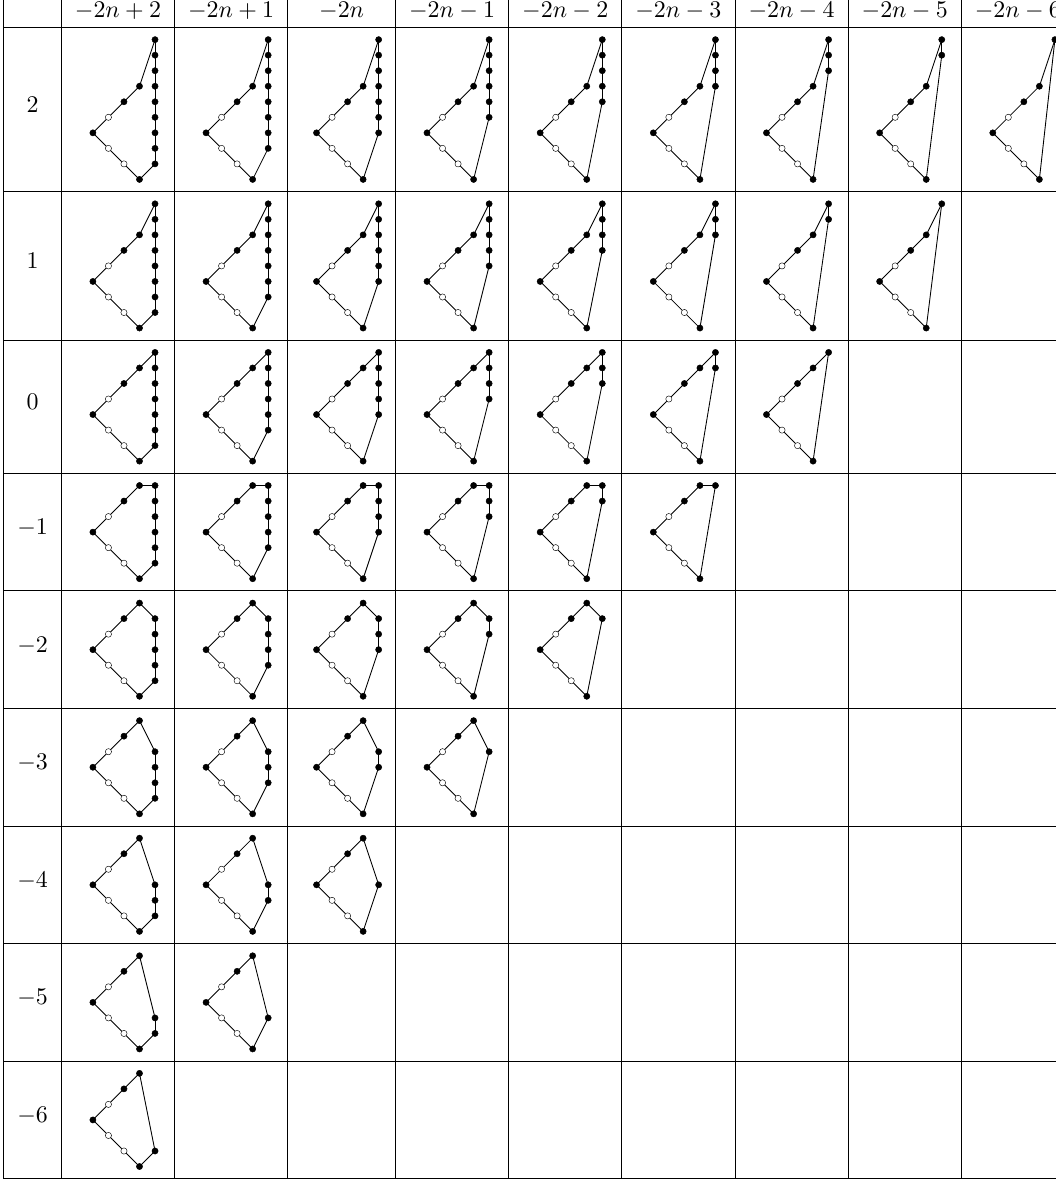
Table 22 . Theories of the form SU(2 n ) k +1 AS + N F F which are descendants of SU(2 n ) n +1 AS +8 F . We label them by ∆ = N F − n − 2 ± k . To illustrate, we have chosen n = 3 , but the structure of ± 2 the table does not depend on n